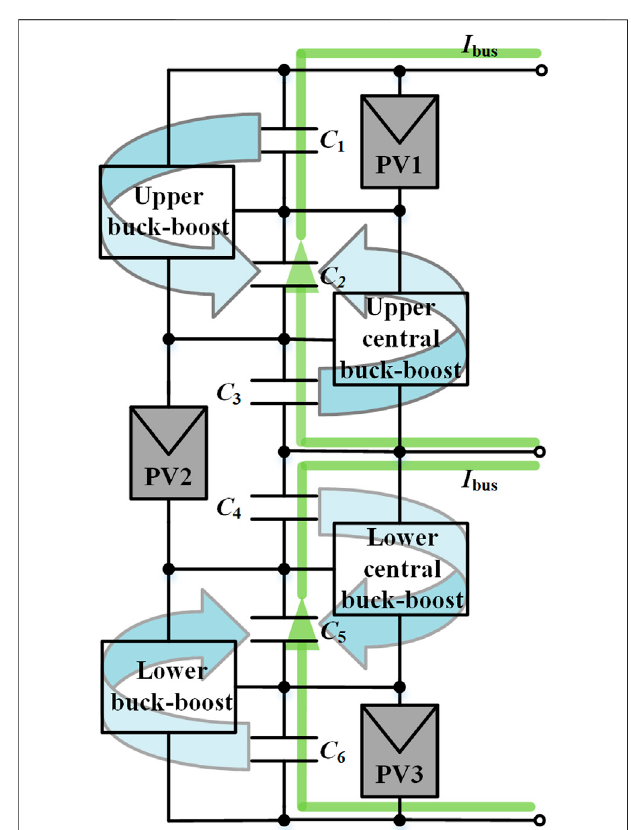
FIGURE 3 | Power fl ow diagram of the proposed